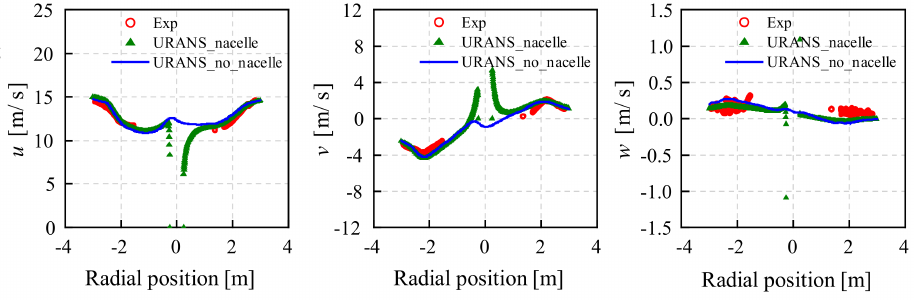
Figure 9. Comparisons of radial velocity distributions at x = − 0.3 m regarding nacelle effect.